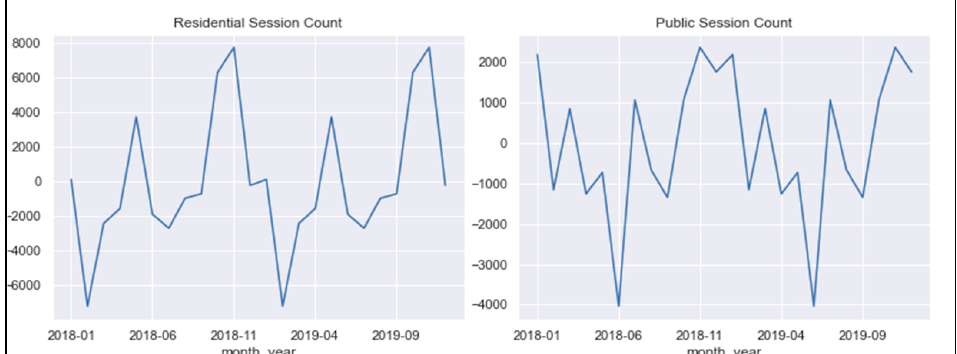
Figure 5. Trend of charging demand for residential and public charging.